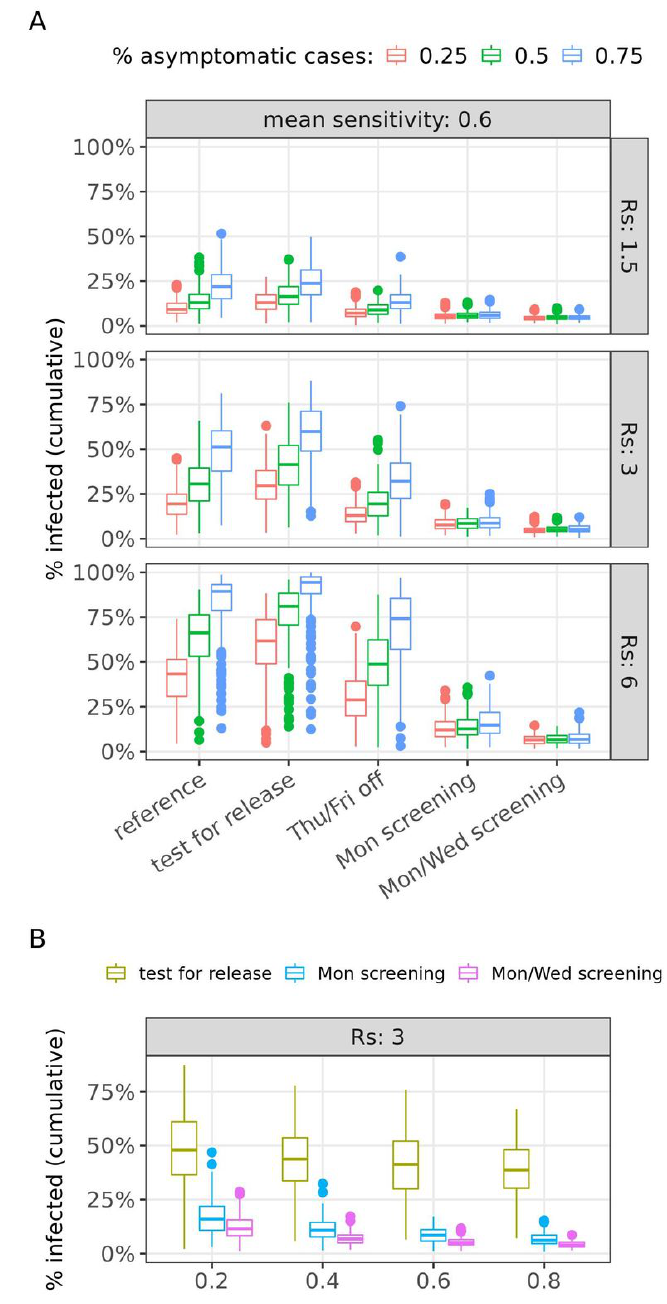
Figure 4. Sensitivity of results to change in key parameters. A: Proportion of infected pupils by and the fraction of asymptomatic cases over a 6-week horizon for a mean lateral flow device (LFD) test sensitivity of 0.6; B: Proportion of infected pupils by mean LFD test sensitivity for (LFD-based policies The differences between policies are most pronounced in the highest infectivity scenario , but the relative performance of the different policies remains stable. As expected, an increased proportion of